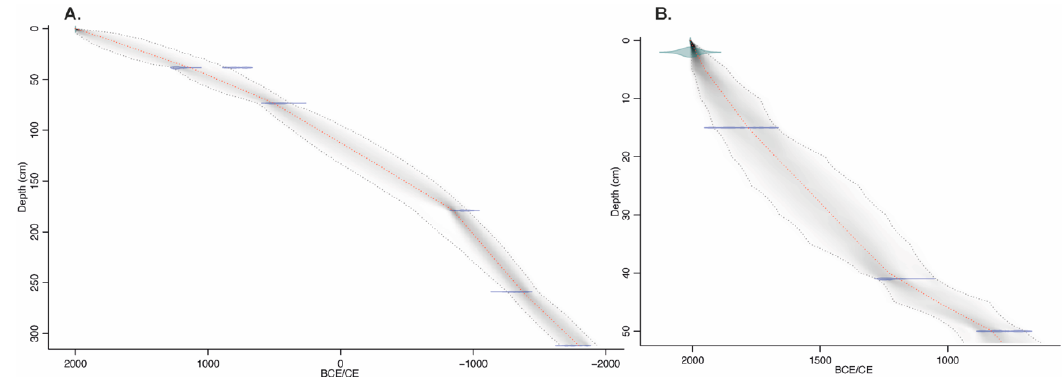
Figure 2. Bayesian age-models of the Lamanai-99 ( A ) and Lamanai-10 ( B ) cores. Grey stippled lines show 95% confidence intervals with the red line representing the single best model based on the mean age for each depth; the shaded area demonstrates most likely age ranges at each horizon. Details of radiocarbon dating, rejected dates, and core correlation are contained in Table 2.